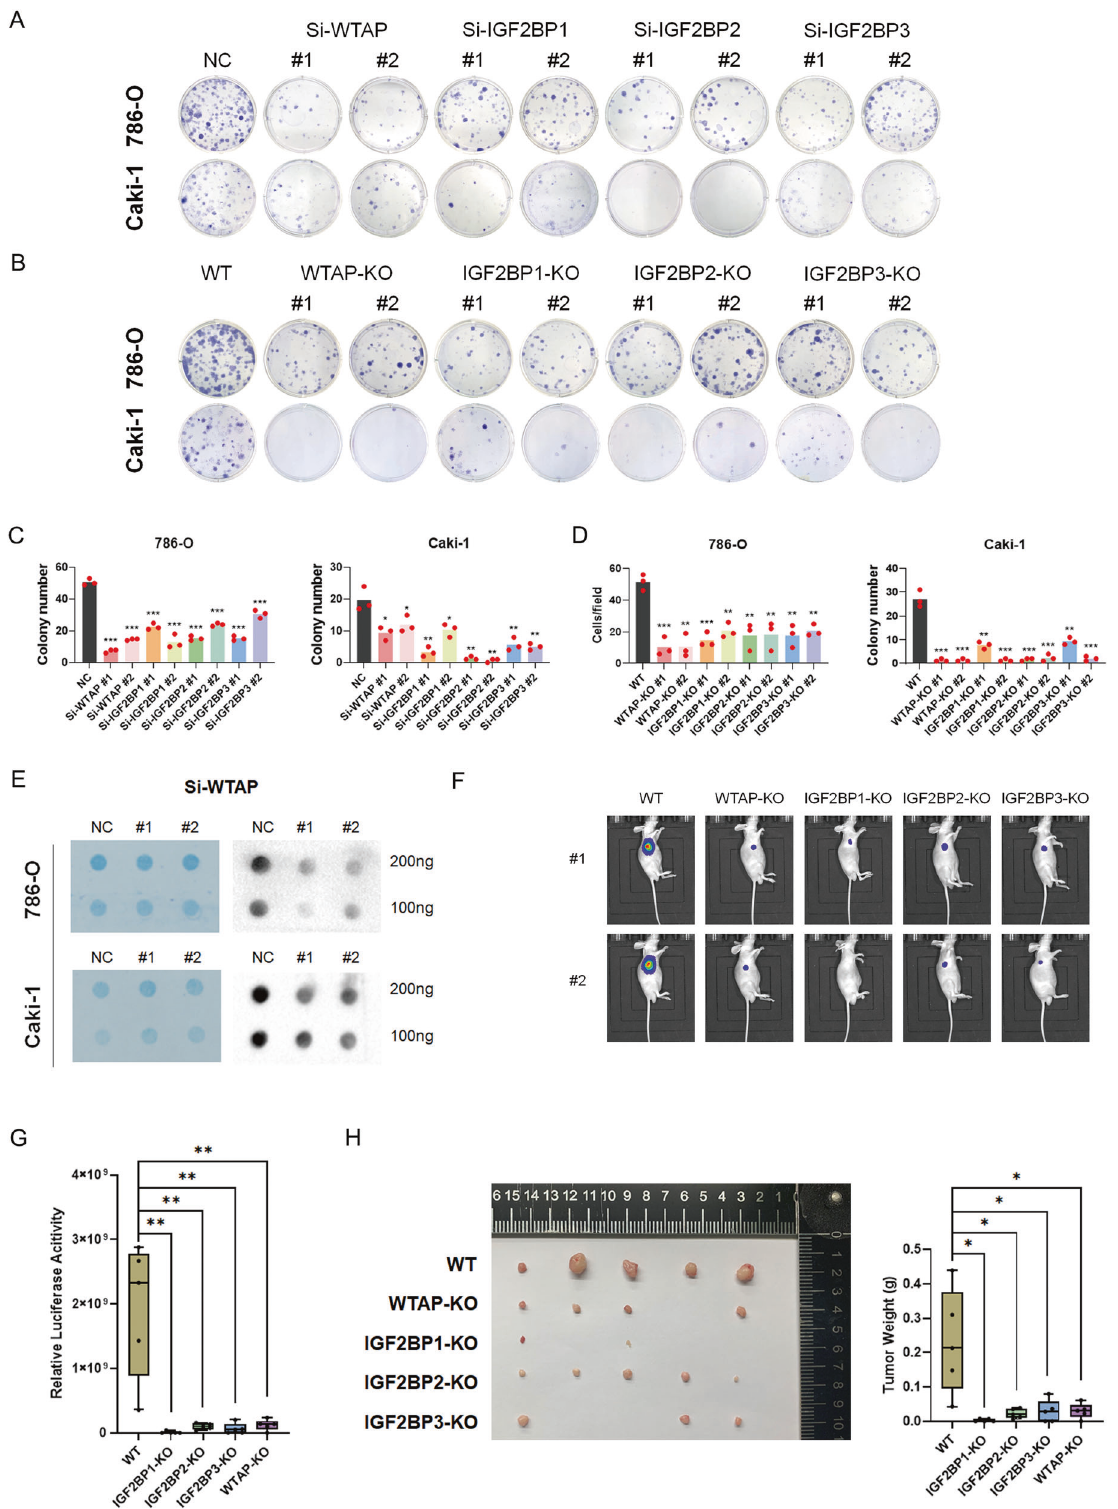
Fig. 4 WTAP and IGF2BPs promote RCC proliferation in vitro and in vivo. A – D Either knockout or knockdown of WTAP and IGF2BPs inhibited RCC colony formation abilities. E M 6 A modi fi cation levels decreased in WTAP knockdown RCC cells. F , G In vivo growth of RCC subcutaneous tumor xenografts based on bioluminescence imaging. H Tumor weights and photographs of xenograft tumors in each group. Values in G and H are mean ± SEM. * P < 0.05; ** P < 0.01; *** P <